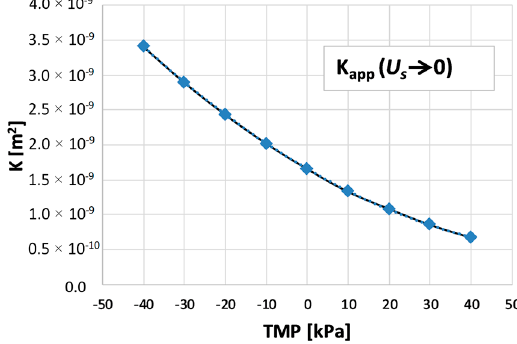
Figure 4. Permeability, K , at U s → 0 as a function of transmembrane pressure for OCF-profiled membranes with P / H = 8, computed by 3-D mechanical CFD simulations [22].